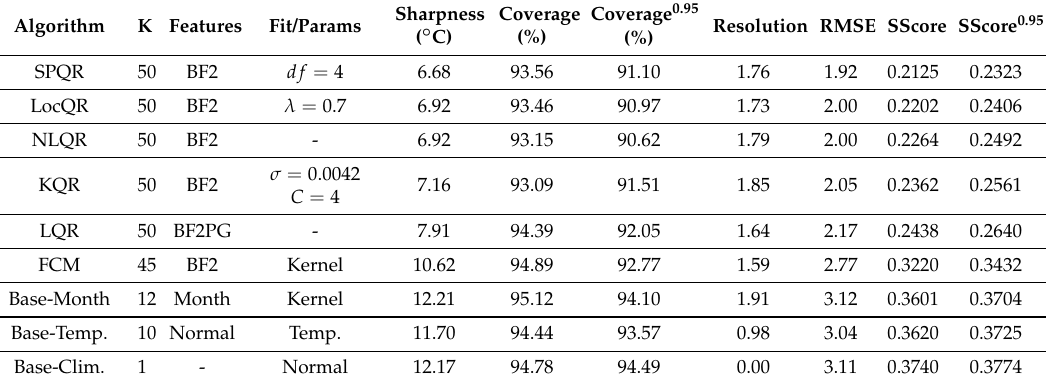
Table 2. PI verification measures for top models of different methods based on three-fold (yearly) cross